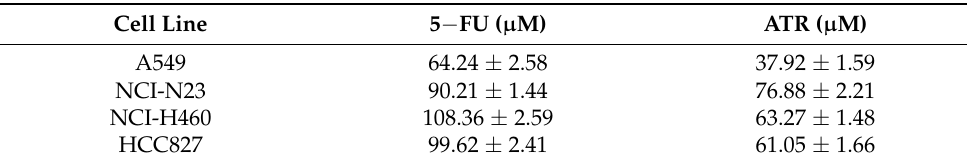
Table 1. IC 50 values of ATR and 5-FU in lung cancer